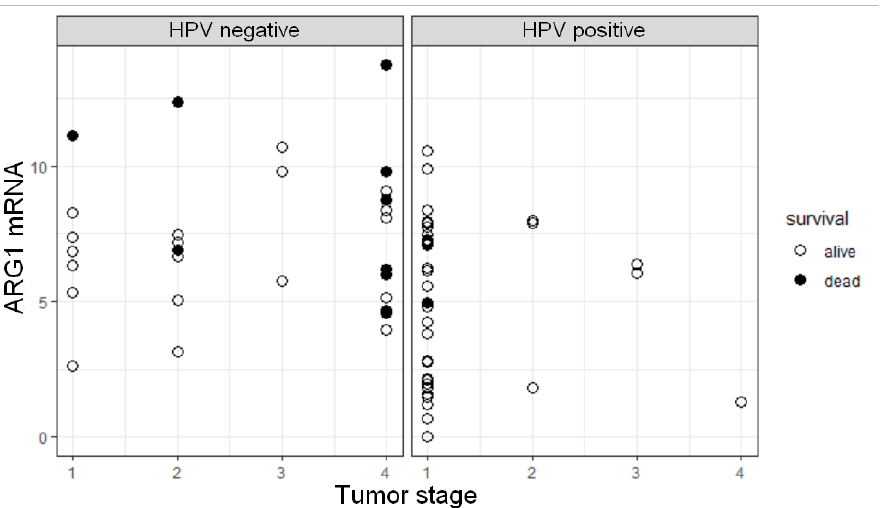
Figure 4. Relationships between ARG1 mRNA expression, tumor pathological stage, and HPV status as the predictors of overall survival. Each point reflects separate observation of a given predictor value.